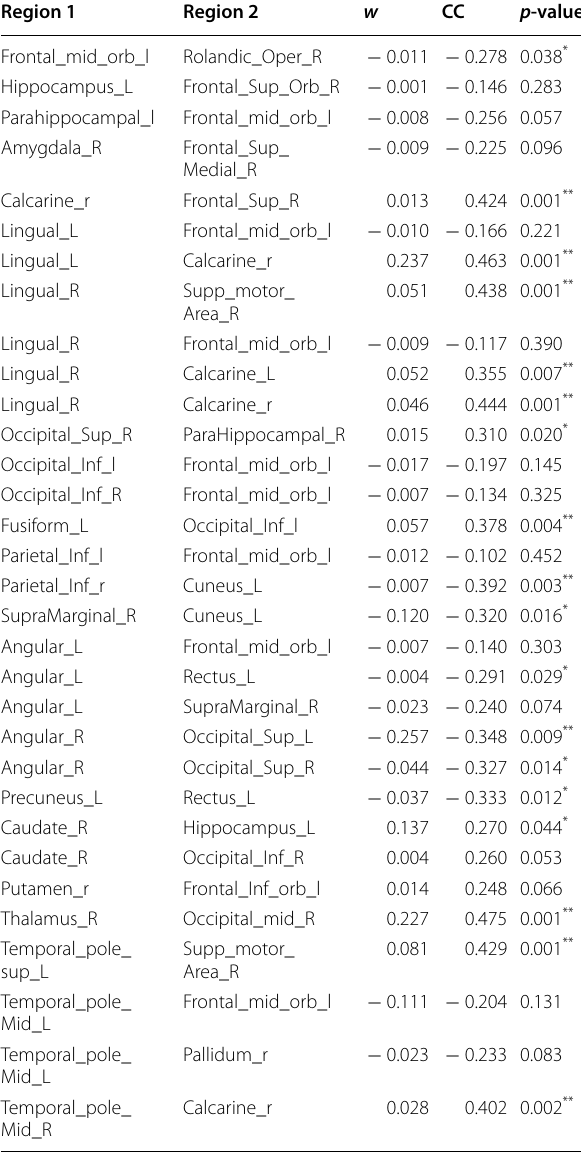
Table 6 The list of the most discriminative features from LASSO, as well as their correlation with the CRS-R scores ( * p < 0.05, ** p < 0.01) Region